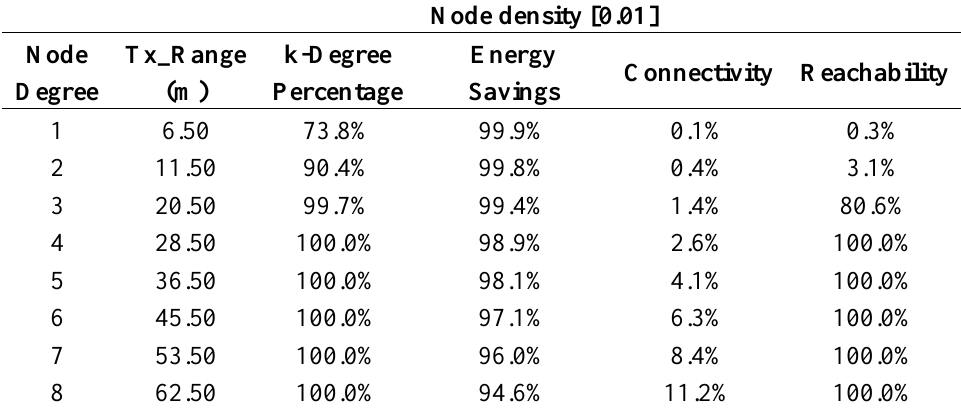
Table 4. The numerical evaluation results for a network with a node density of 0.01 nodes/m 2